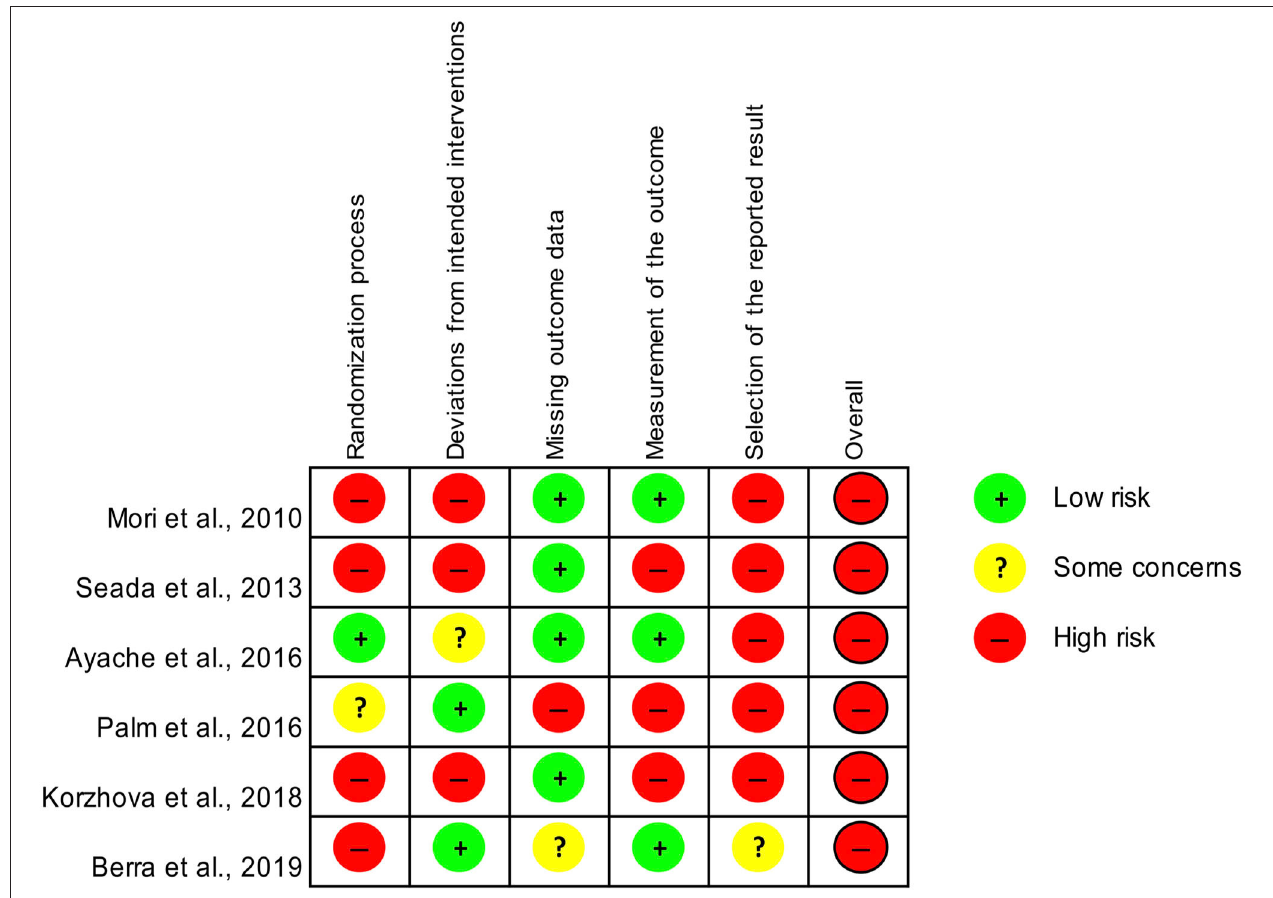
FIGURE 2 | Assessment of the risk of bias for controlled studies included in the systematic review according to the RoB 2.0